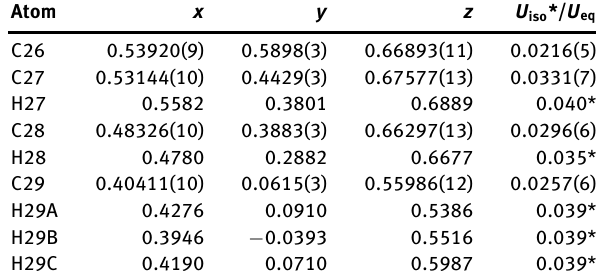
Table 2: Fractional atomic coordinates and isotropic or equivalent isotropic displacement parameters (Å 2